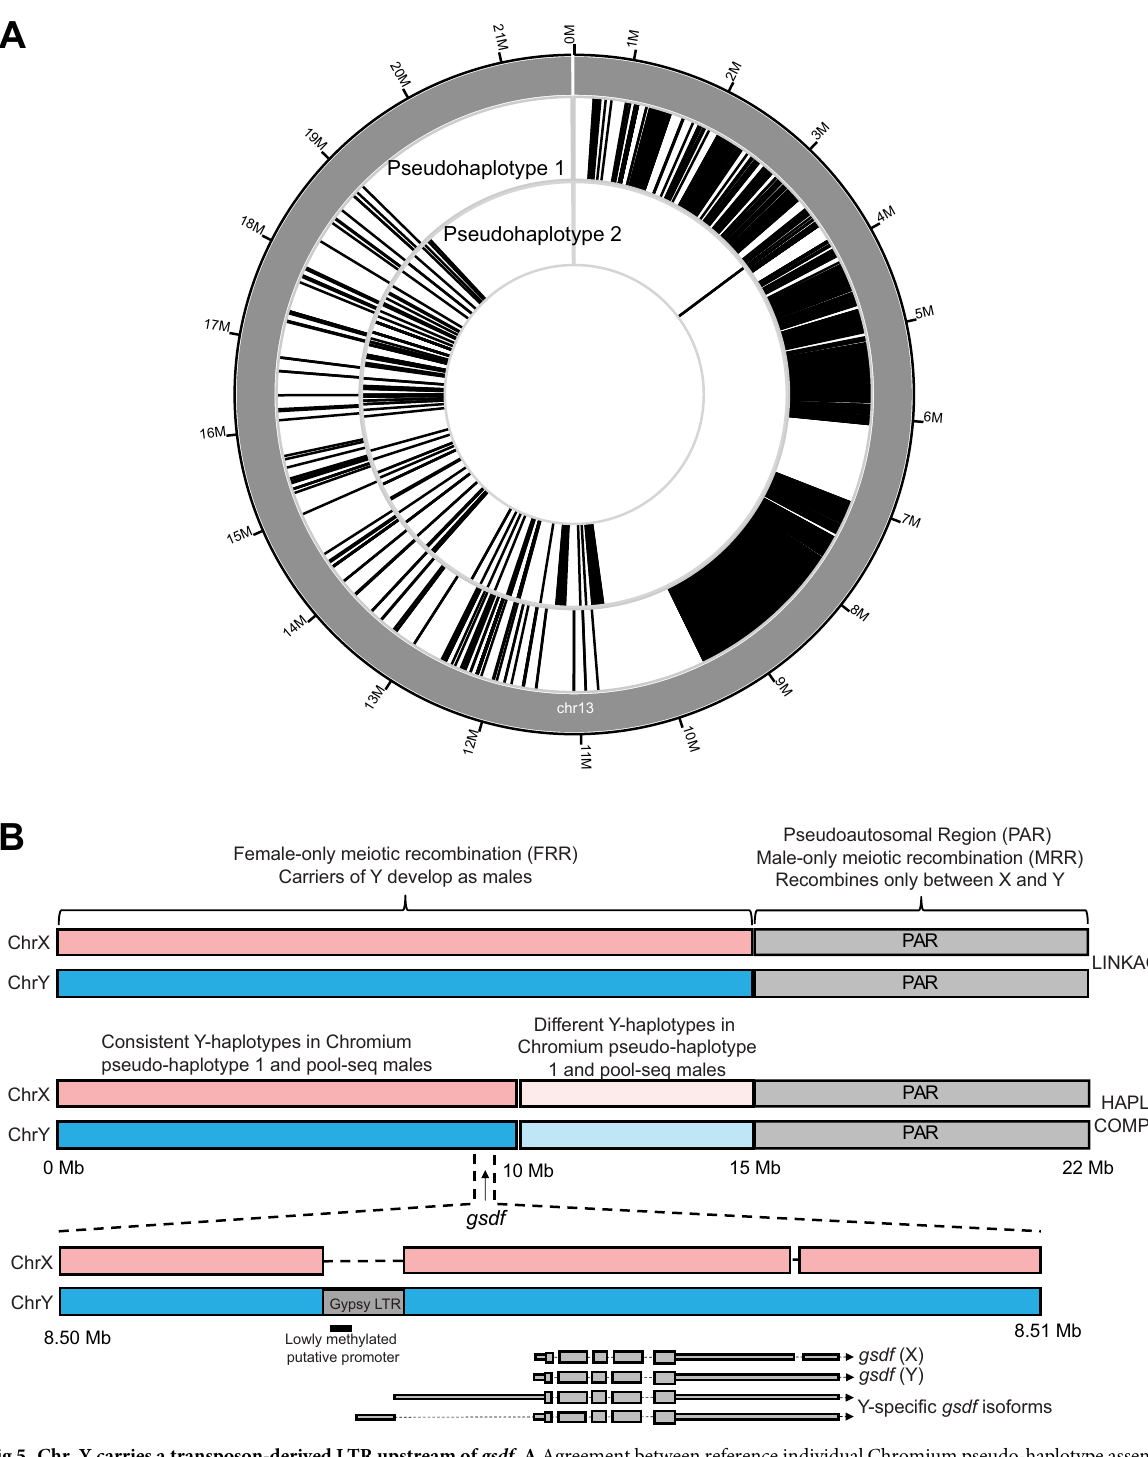
Fig 5. Chr. Y carries a transposon-derived LTR upstream of gsdf . A Agreement between reference individual Chromium pseudo-haplotype assemblies and chrY-markers from Pool-seq of males and females. Black lines show markers along chr13 where pseudo-haplotype 1 (outer track) and pseudo-haplotype 2 (inner track) are in agreement with the Y-allele defined from pool-seq. In the interval 0-10Mb pseudo-haplotype 1 shows a striking agreement with Y- markers defined from pool-seq data. B Schematic representation of the Atlantic Halibut sex chromosomes as inferred from linkage analysis alone and from comparison of Pool-seq defined Y-markers with Chromium pseudo-haplotypes of the assembly male. X and Y haplotypes differ for a 1.2 kb segment